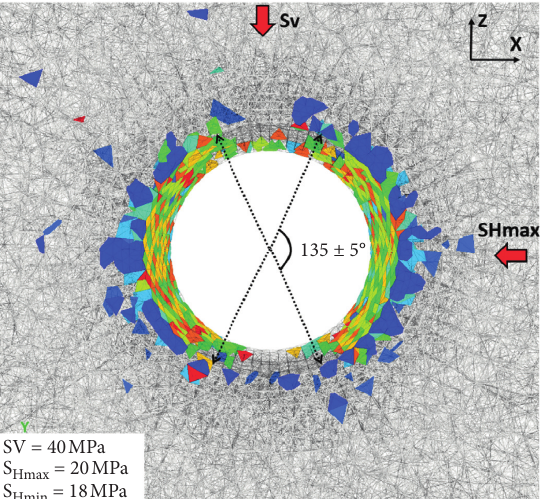
Figure 15: XZ plane view of the wellbore, with colored blocks representing failed rock fragments.